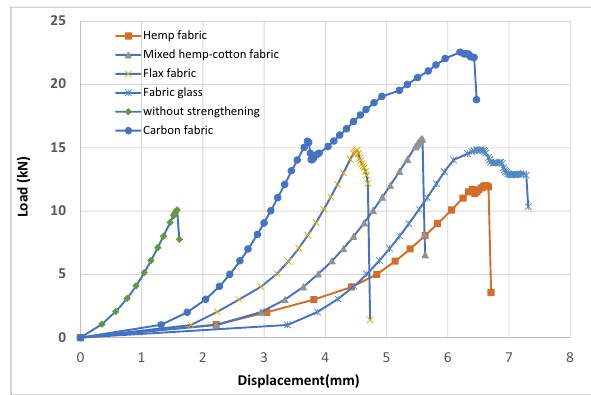
Figure 9: Mechanical behavior of the strengthened concrete beams according to the di ff erent types of composite fi ber fabrics using the LVDT